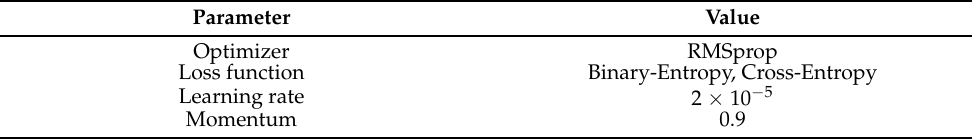
Table 3. CNN training hyper-parameters.